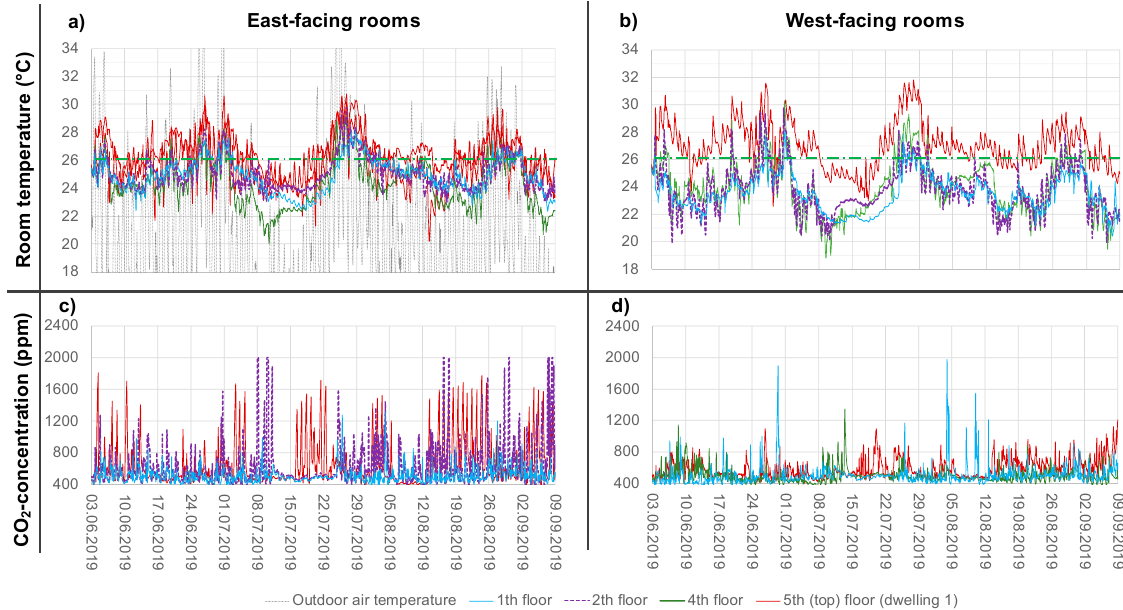
Figure 3. Monitored room temperature ( a , b ) and CO 2 -concentration ( c , d ) time series of east (left) and west façade (right) oriented rooms of dwellings in the GZH building, according to their floor level location. A comparison of the two top floor dwellings can be found in the Appendix A (cf. Figure A2) .